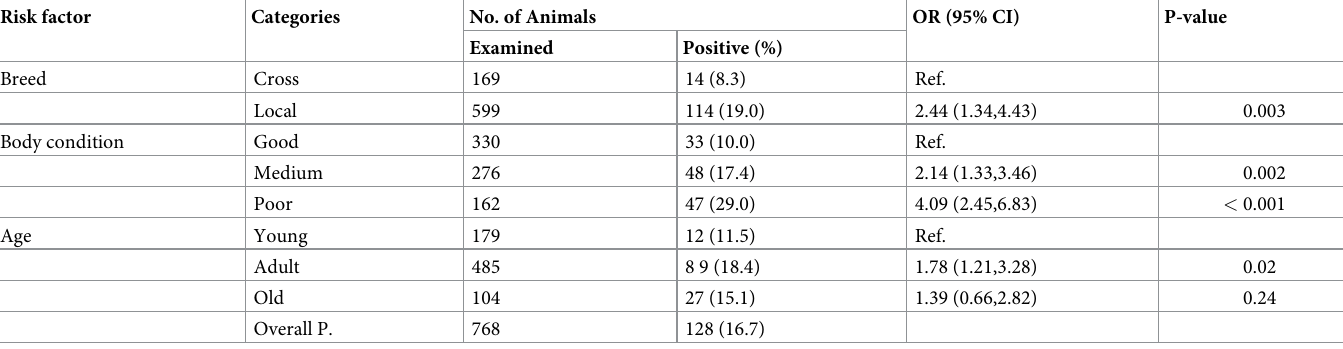
Table 2. Multivariable mixed-effect logistic regression risk factor analysis with the prevalence of S.bovis .